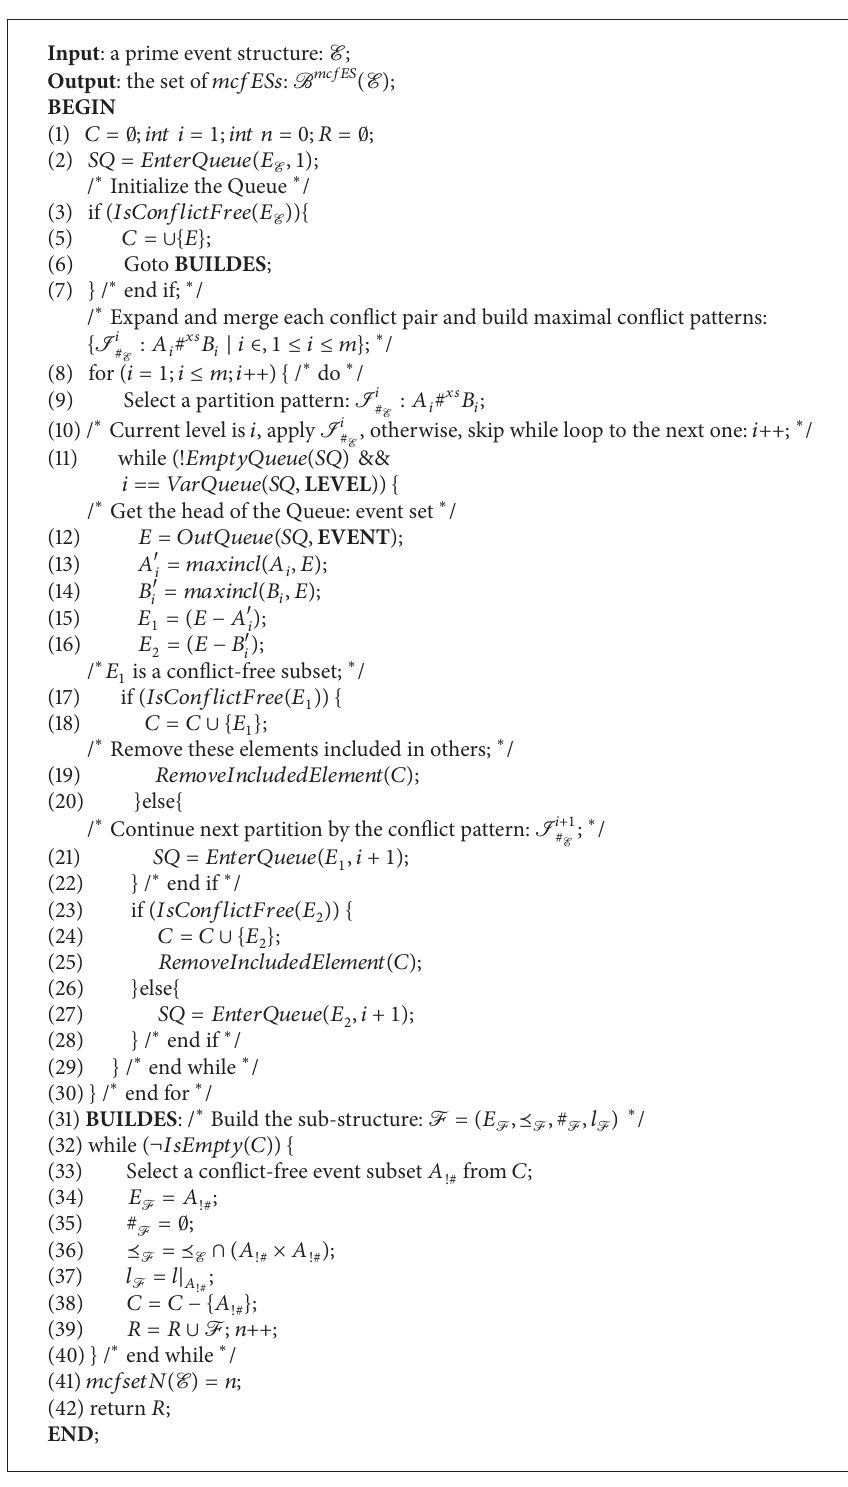
Algorithm 1: Conflict-free partition: 𝑐𝑓𝑝